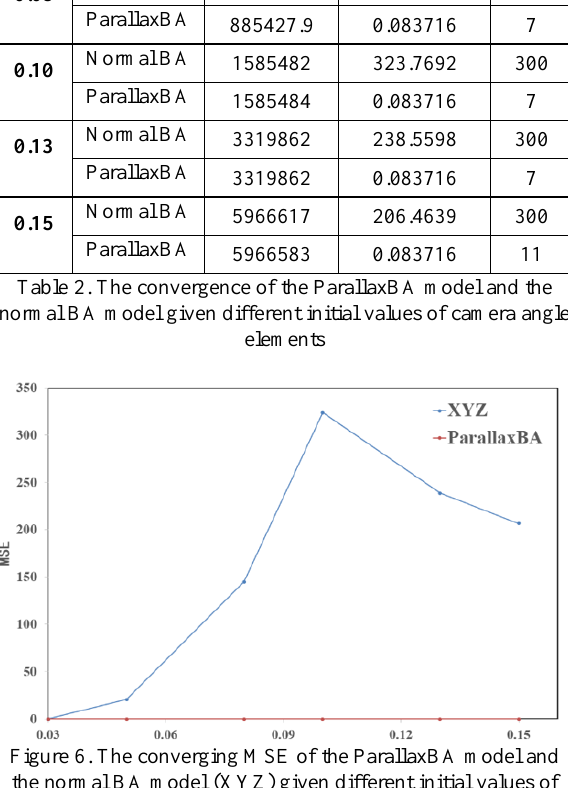
Figure 4. The ortho-rectification and mosaic result of the UAV dataset